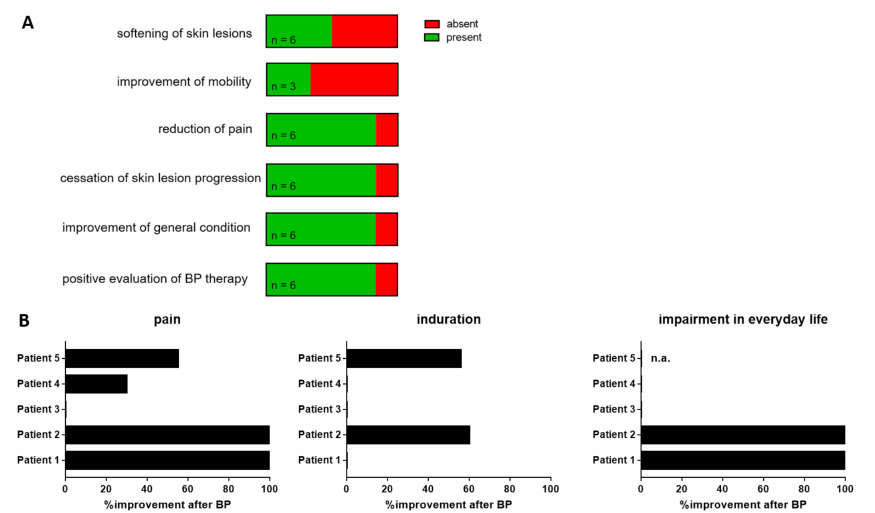
Figure 1. Patient’s subjective evaluation of bisphosphonate therapy effects. ( A ) Absence or presence of different treatment outcomes after initiation of bisphosphonate therapy as assessed by a postal questionnaire. ( B ) Percent improvement of pain, induration of calcinosis cutis skin lesions and impairment in everyday life after initiation of bisphosphonate therapy for each individual patient taking part in the questionnaire evaluation.